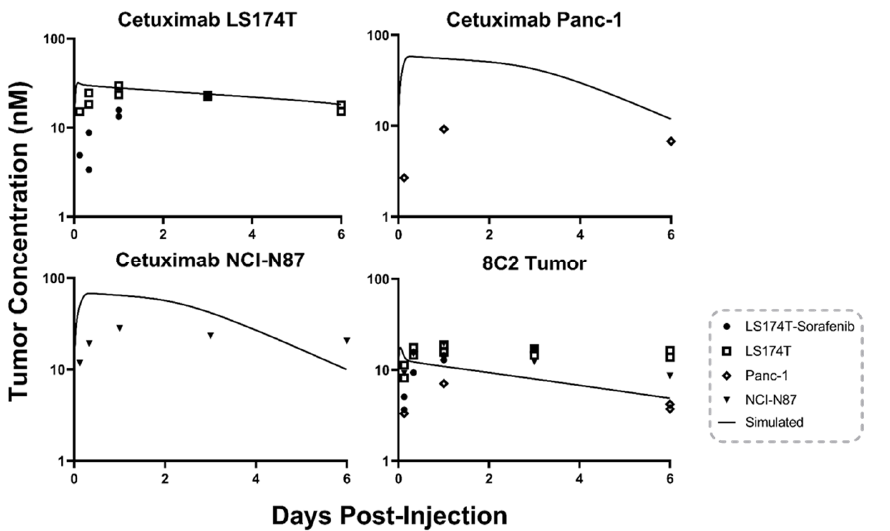
Figure 4. Base PBPK Model Prediction: The tumor concentration over time profile predictions made using the base PBPK model for 8C2 (bottom right) and cetuximab. Points represent the observed antibody concentration for a single xenograft. Cetuximab predictions are separated into three panels as cell-line specific EGFR concentrations were incorporated into the cetuximab model predictions.